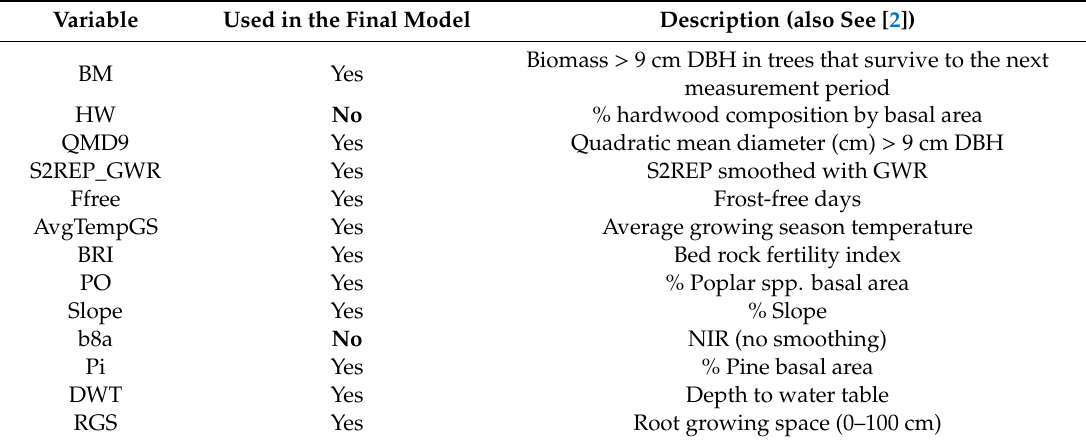
Table 5. List of the site and Sentinel-2 variables used for model